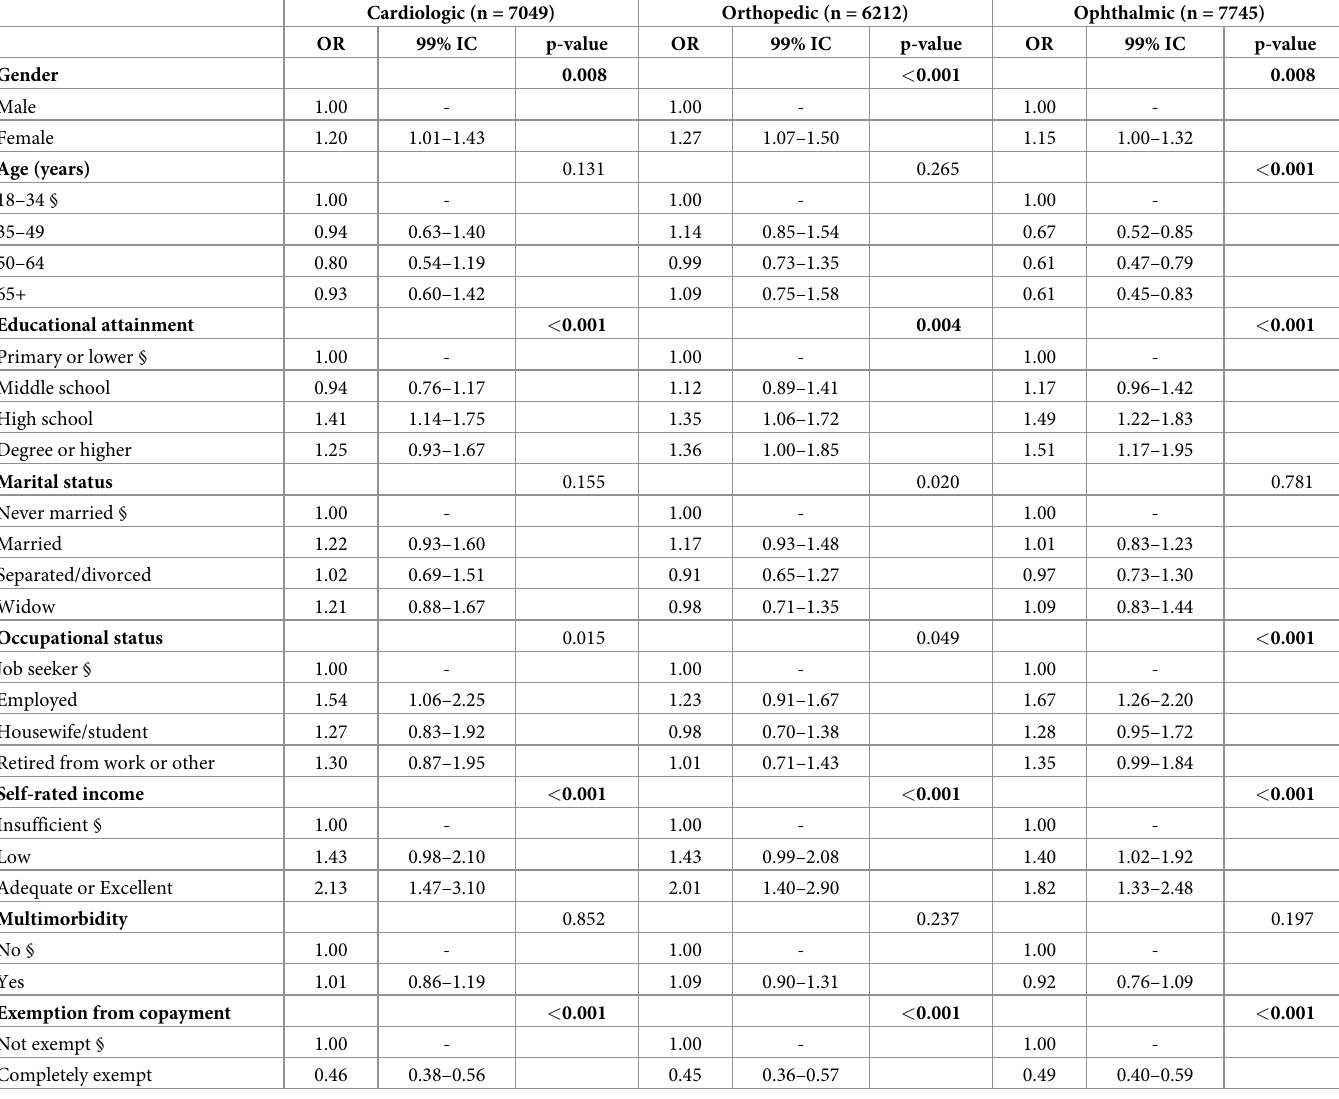
Table 2. Factors associated with use of private services for cardiologic, orthopedic and ophthalmic visits: Results of multivariable logistic